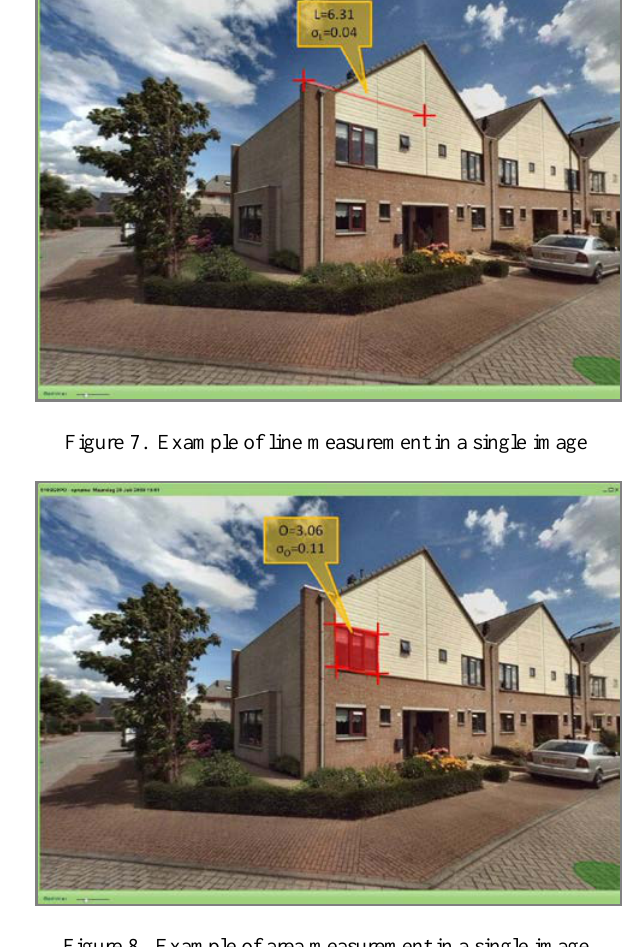
Figure 8. Example of area measurement in a single